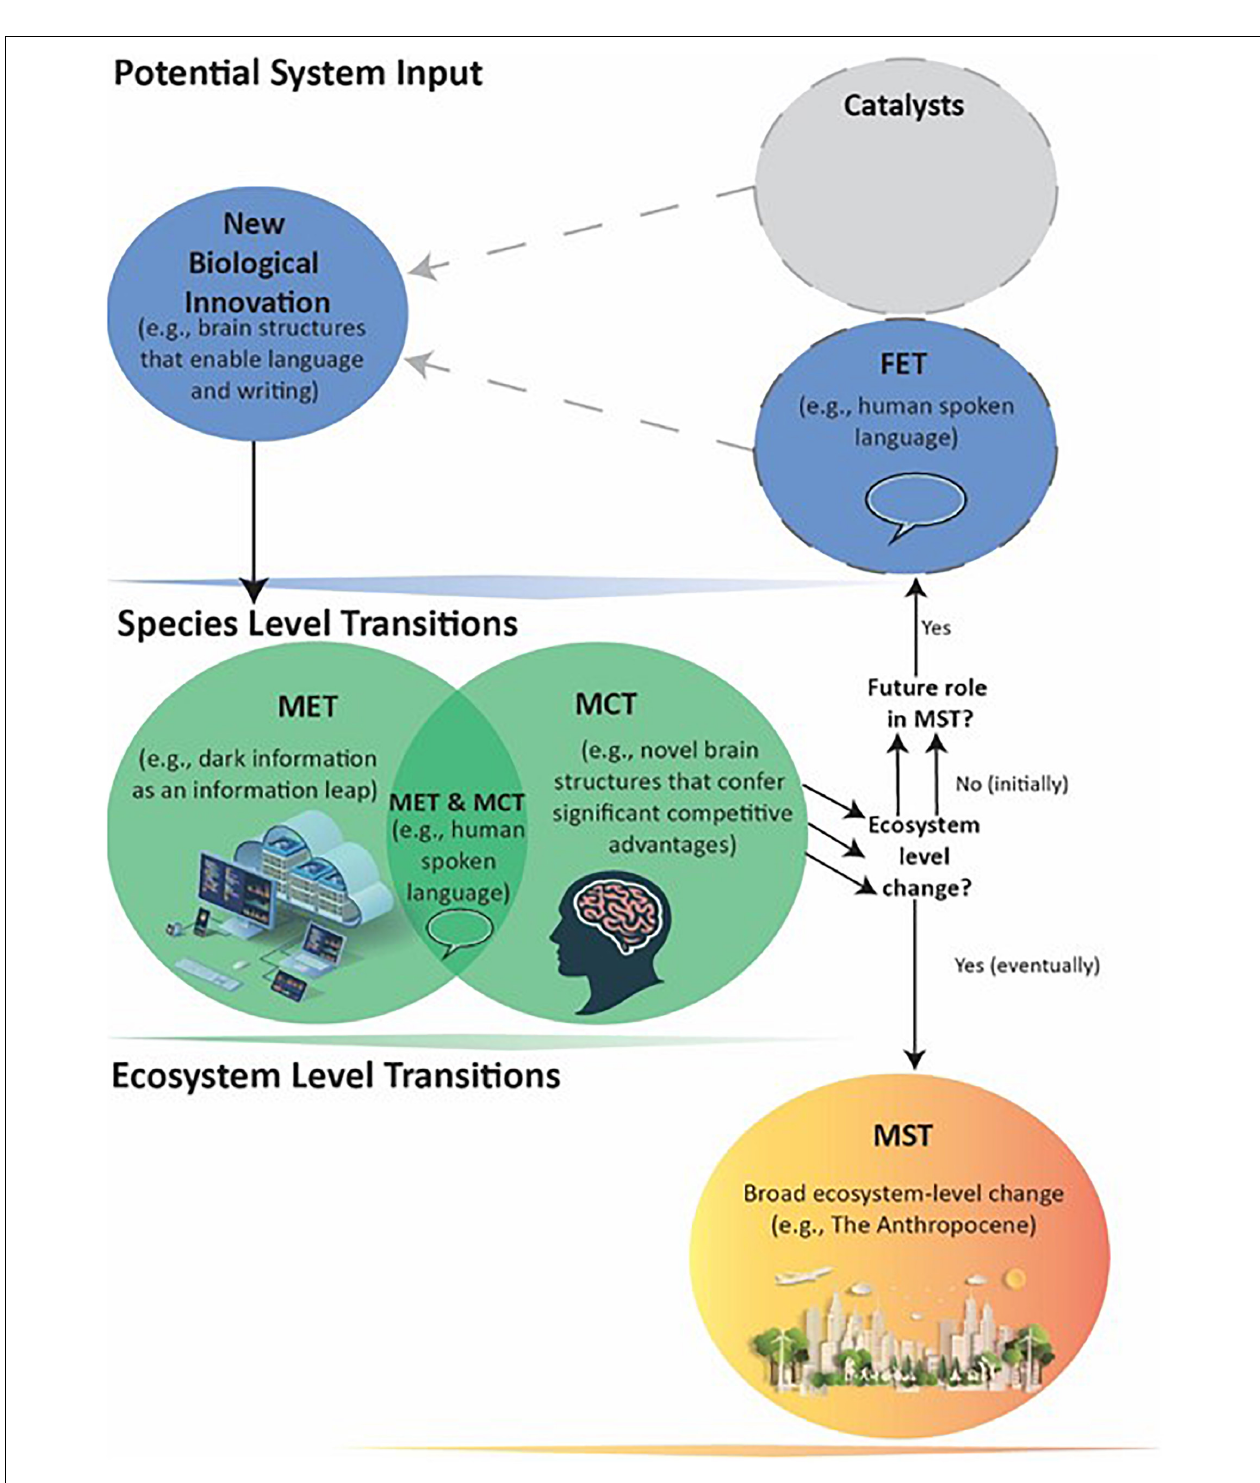
FIGURE 4 | Human evolution leading to a MST. Humans produced broad Ecosystem-level effects through a combination of METs (e.g., spoken language in a Level III Information Leap) and MCTs (e.g., increased intelligence with larger brains). These became separate and essential FETs, as indicated by the multiple arrows, that eventually enabled the Level IV Information Leap MET of storable symbolic language and the MST. As MSTs can ‘set the stage’ for future METs, MCTs, and MSTs, it is thus possible that human-created technologies (e.g., robotics combined with Level V artificial intelligence) will lead to a future major transition that melds the biotic and abiotic into a new